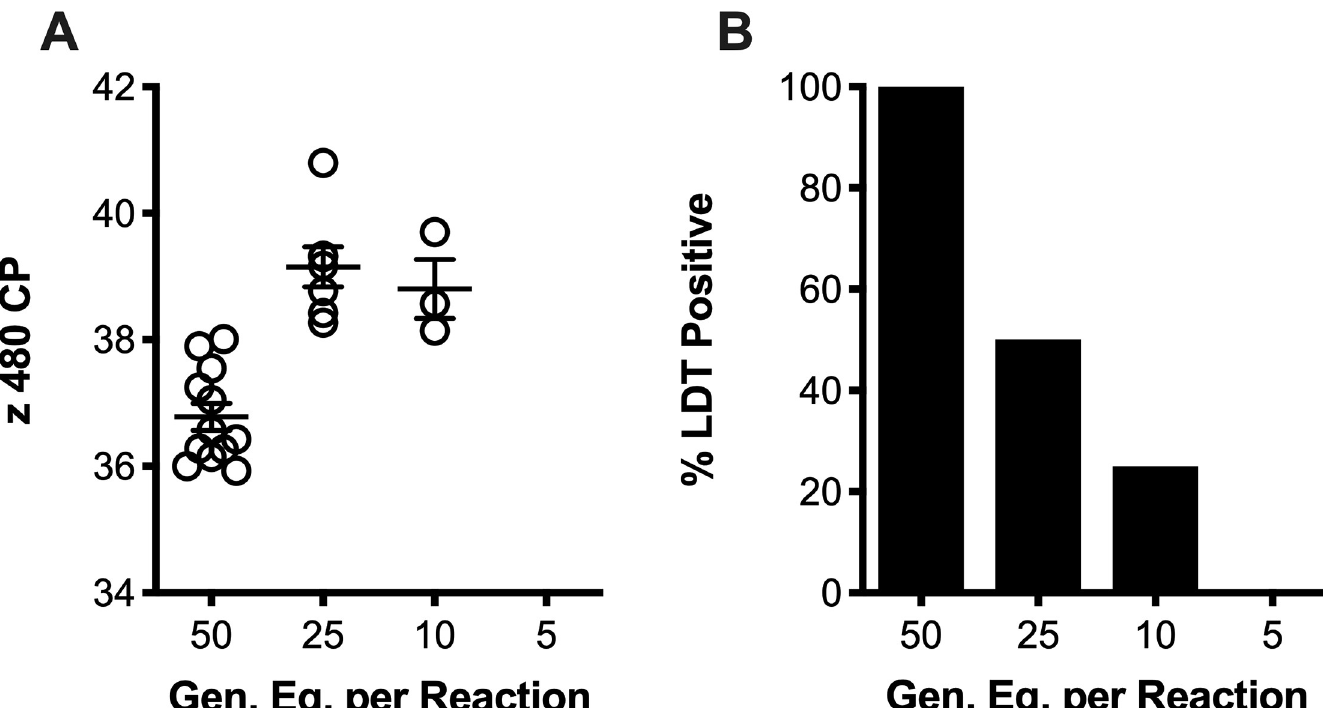
Fig 2. Empirical determination of the lower limit of detection (LOD). Serial dilutions of purified T . vaginalis organisms in ThinPrep PreservCyt specimens, corresponding to 50, 25, 10, and 5 genomic equivalents per reaction, were tested in replicate reactions (n = 12 each). Data are presented as (A) x 480 crossing point (CP) values, and (B) the percent of positive results observed from the replicate reactions for each of the serial dilutions. Probit regression analyses was used to accurately ascertain the LOD with 95% confidence. Data presented in this figure are representative of spin-column purified specimens; the Probit-derived LOD for spin column- and x 480-purified specimens is presented in the results section.